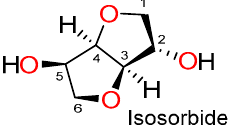
Figure 1. Chemical structure of isosorbide.